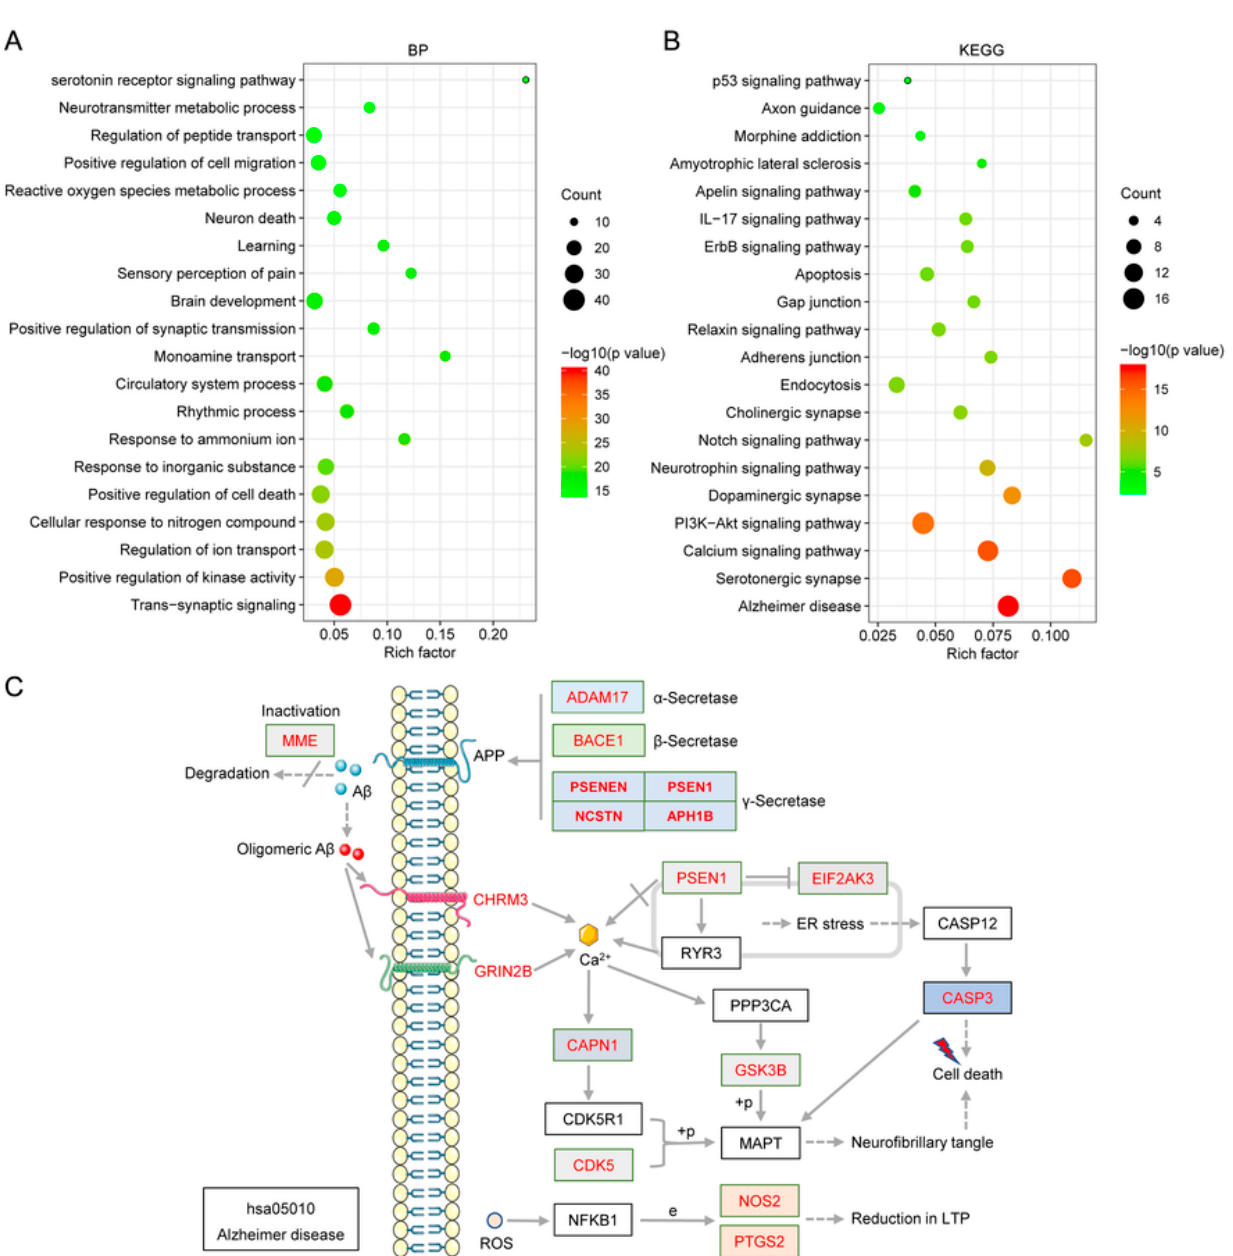
Figure 6. GO biological process (BP) ( A ) terms and the results of KEGG ( B ) pathway enrichment analysis of target proteins of UR alkaloids against AD. The X-axis represents the rich factor, the bubble size represents the number of targets enriched in terms, and the color indicates the p -value. ( C ) Schematic drawing of the Alzheimer disease pathway (hsa05010). Red font indicates the targets of UR alkaloids involved in the Alzheimer disease pathway.